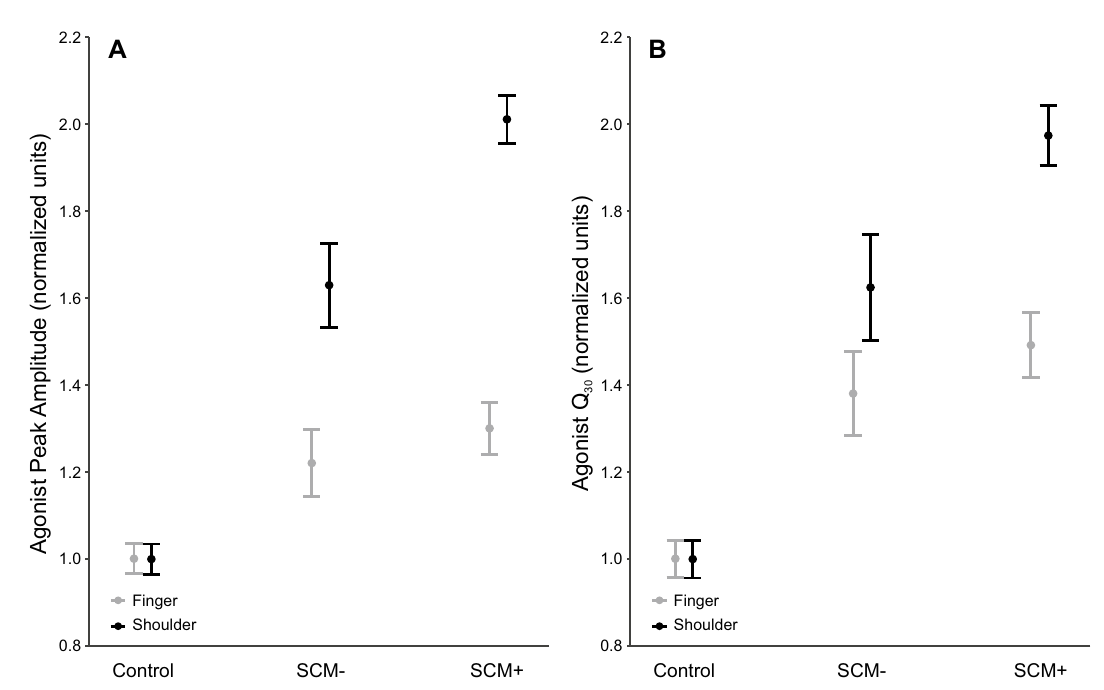
Figure 2. Task-related EMG variables (n = 3793 data points), separated by control trials and startle trials in which activation in the sternocleidomastoid (SCM) was either absent (SCM −) or present (SCM +). Panel ( A ) shows peak agonist amplitude (normalized to control values) whereas panel ( B ) shows normalized agonist Q 30 . Significant interaction effects were found for both variables (p < 0.001), due to significant differences between all conditions except for SCM + versus SCM − for the finger task and between control conditions. Error bars represent 95%